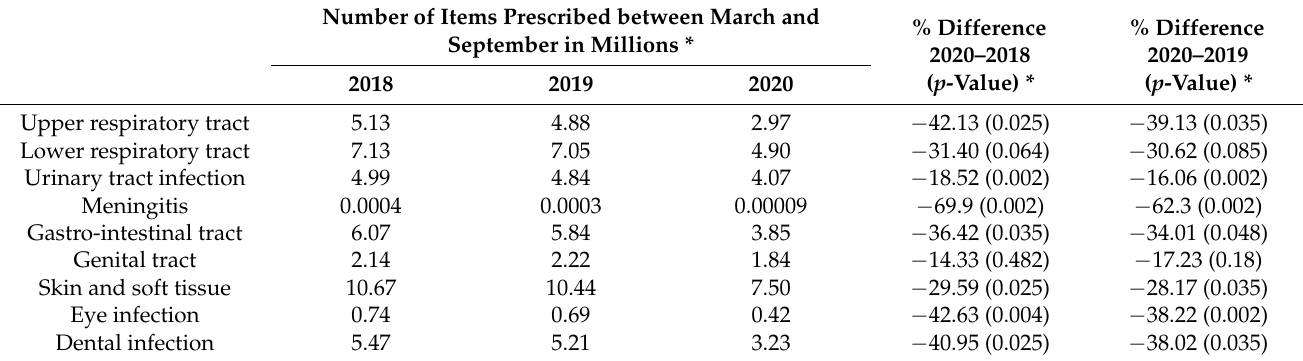
Table 2. Number of antibiotics prescribed (in millions) as per anatomical infection sites.